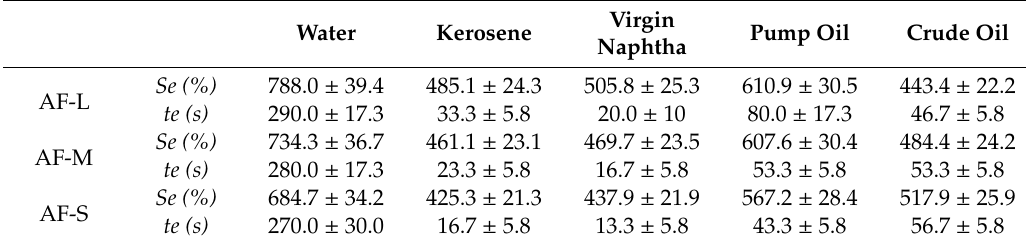
Table 3. Sorption capacity and time at equilibrium parameters for all liquids and all investigated AD fiber